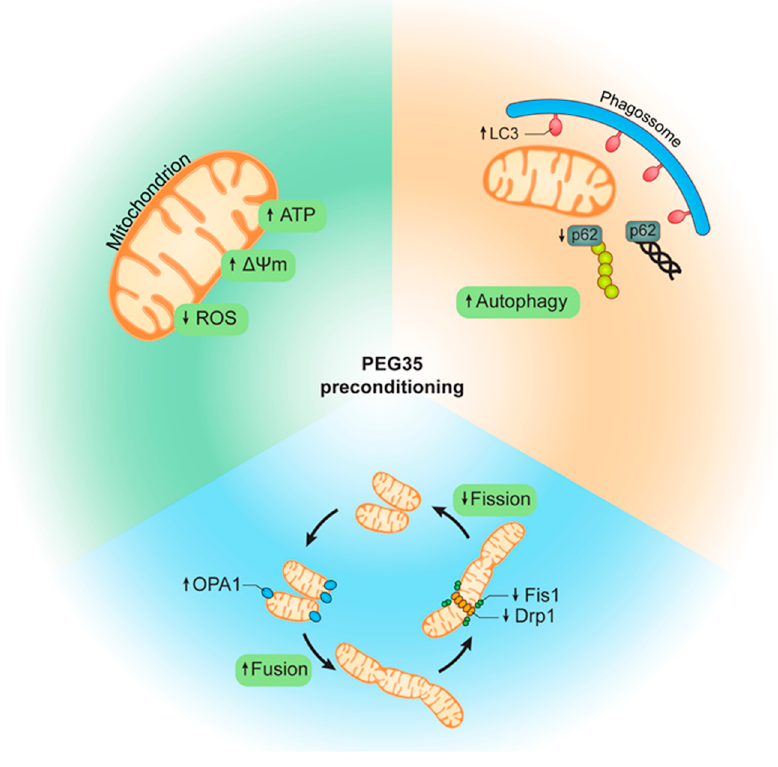
Figure 6. Schematic representation of PEG35-mediated protection following hypoxia/reoxygenation injury. PEG35 preconditioning alleviates mitochondrial dysfunction, including the recovery of mitochondrial membrane potential and ATP levels and the reduction of ROS production. In addition, PEG35 treatment suggests enhanced autophagy and a modulation of mitochondrial biogenesis via increased mitochondrial fusion and decreased mitochondrial fission following hypoxia/reoxygenation injury.